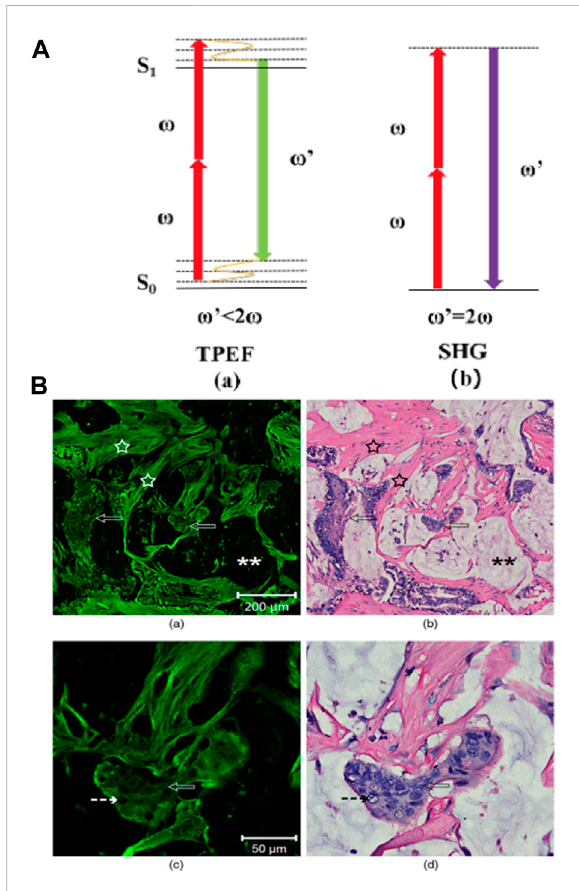
FIGURE 4 (A) Schematic of energy level transitions of (a) two-photon excited fl uorescence (TPEF) and (b) second harmonic generation (SHG). (B) Comparison of representative multiphoton microscopy (MPM) and hematoxylin and eosin (H&E) images inpancreatic colloid carcinoma. Open arrows indicate the nest of cancerous tissue; pentagrams denote collagen fi bers; asterisks represent mucous lakes; and dashed arrows indicate cancer cells [62,